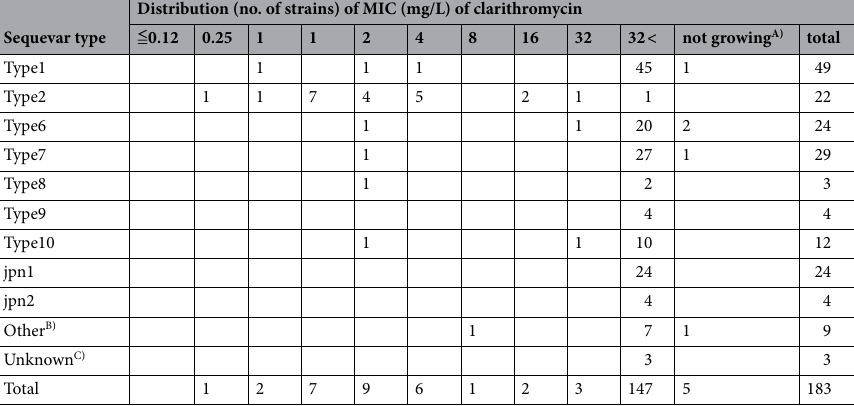
Table 5. erm (41) sequevar type and clarithromycin minimum inhibitory concentration (MIC) of M. abscessus subsp. abscessus (MAB). A) These strains did not grow sufficiently in the control well, and MIC could not be determined. B) Other rare sequevar types. These types did not include types 3, 4, and 5. C) PCR was performed to obtain a product, but sufficient erm (41) gene sequence data could not be obtained.